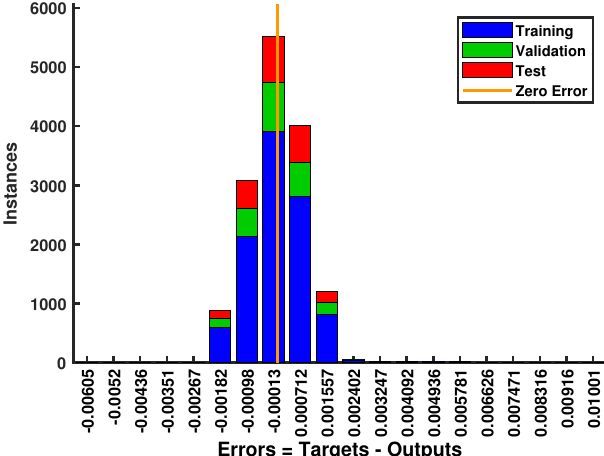
Figure 10. The error histogram with 20